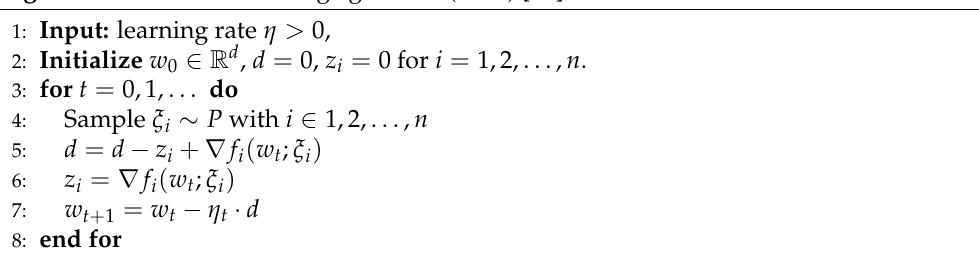
Algorithm 3 Stochastic average gradient (SAG) [48].